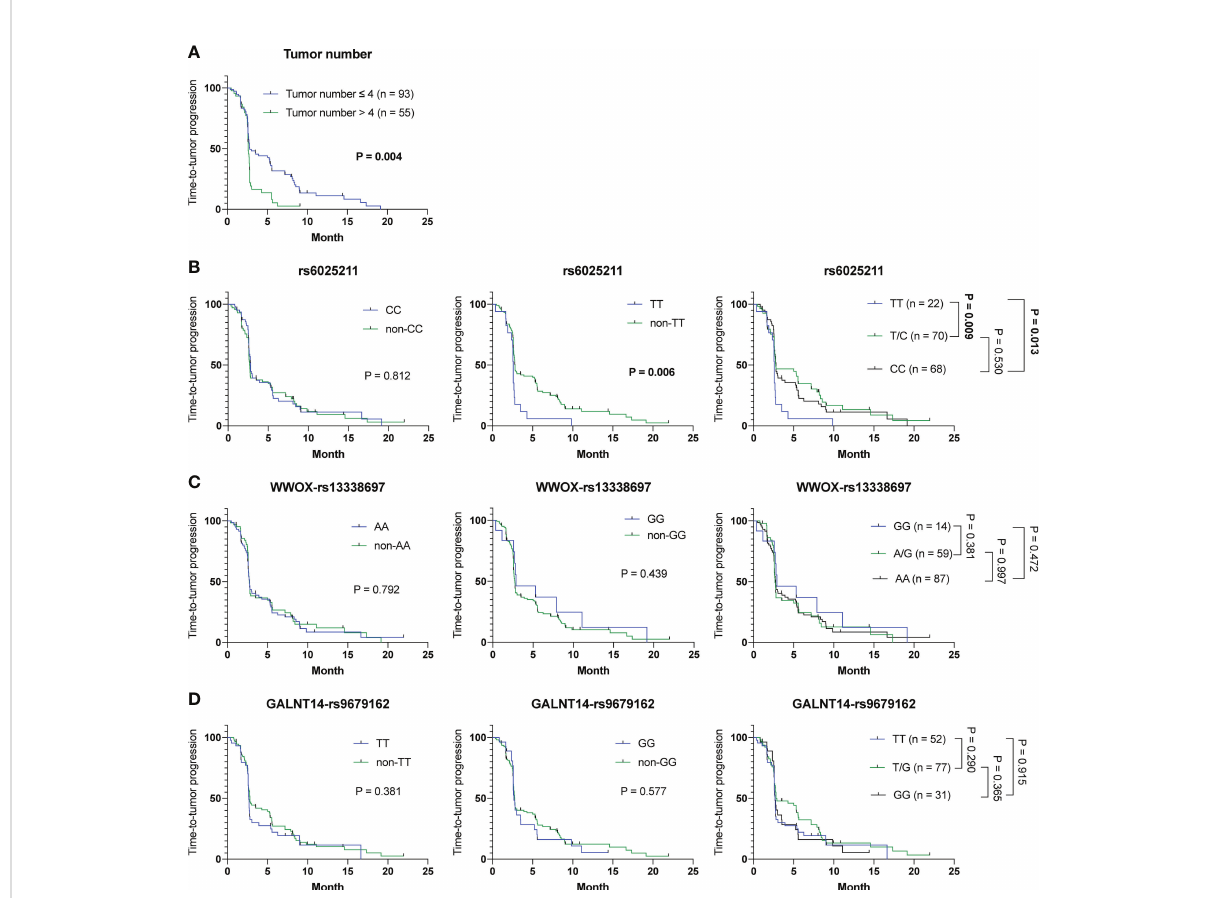
FIGURE 4 Analysis of clinicopathological factors and SNP genotypes in association with TTP in all 160 HCC patients experiencing ADI-PEG 20 therapy. Kaplan-Meier analysis of subgroups of patients with HCC strati fi ed by (A) tumor number, (B) rs6025211, (C) WWOX -rs13338697, and (D) GALNT14 -rs9679162 genotypes. P values were obtained by log-rank test, and < 0.05 was considered signi fi